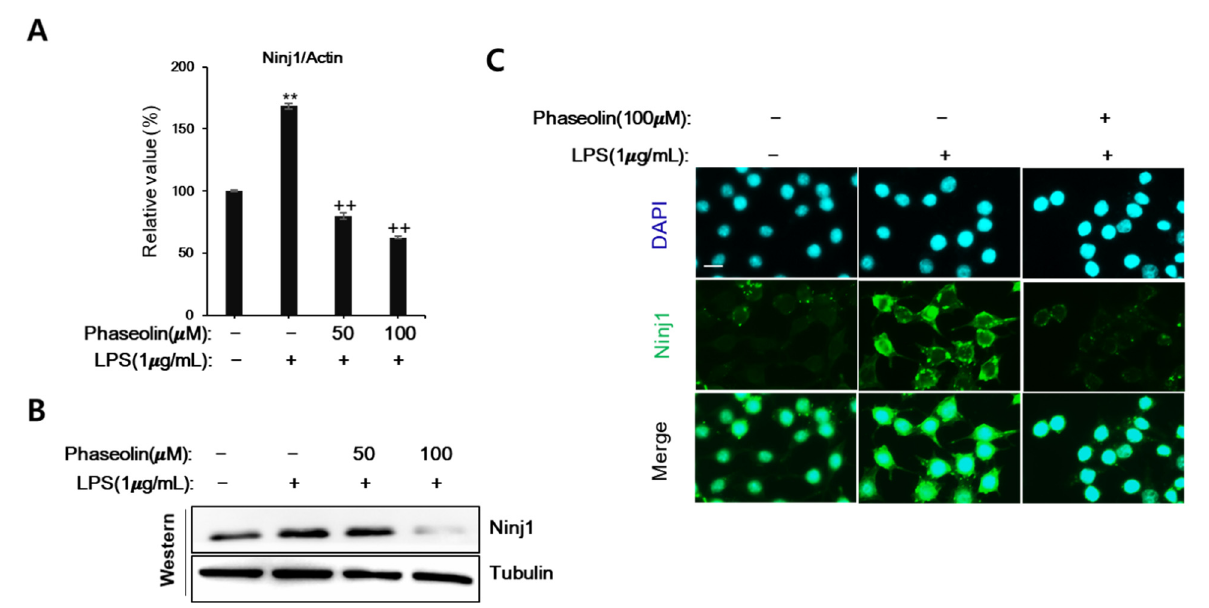
Figure 4. Effects of phaseolin on Ninjurin1 (Ninj1) expression, in vitro. RAW 264.7 cells were treated with LPS (1 μ g/mL) alone or LPS + phaseolin (50 or 100 μ M) for 24 h and then Ninj1 expression was assessed using real-time polymerase chain reaction (PCR) ( A ) and Western blotting ( B ). ( C ) Immunofluorescence staining of Ninj1 (green). Nuclei were stained with 1 μ g/mL DAPI (blue). A scale bar indicates 10 μ m. ** p < 0.01, vehicle vs. LPS-treated group; ++ p < 0.01, LPS vs. LPS + phaseolin-treated group.